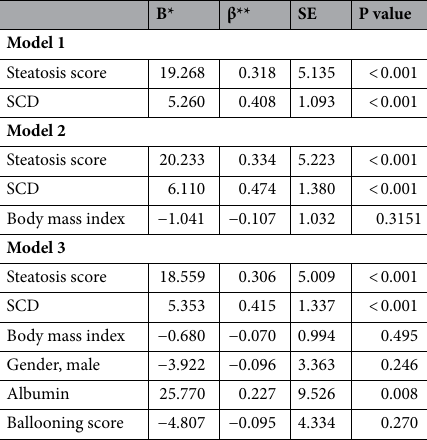
Table 4. Multiple regression analysis for factors associated with CAP. Multiple regression analysis of individual models. *Partial regression coefficient and **standard partial regression coefficient. Abbreviations: SE, standard error; SCD, skin–capsular distance.